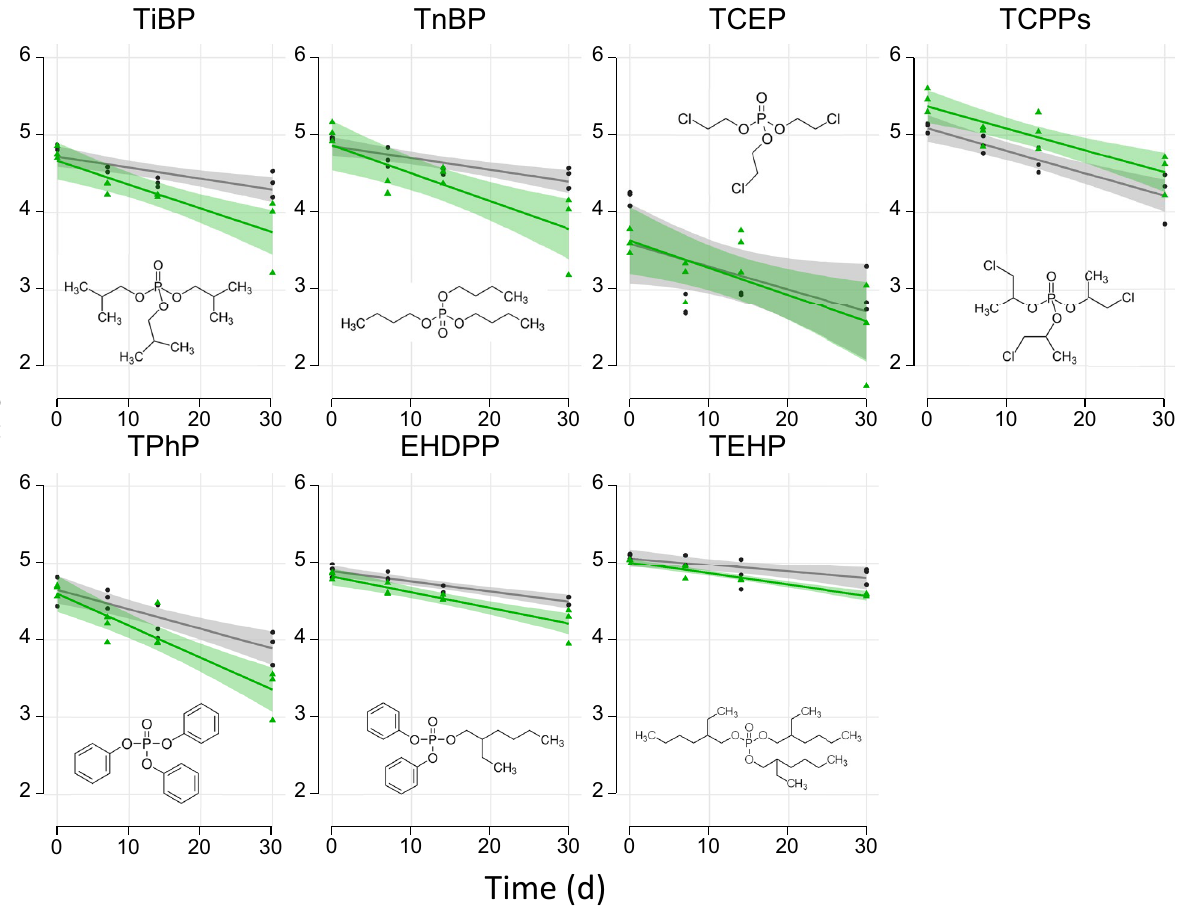
Figure 1. Linear regression analysis between the individual OPE concentrations (as Ln C) and the incubation time (days). Gray and green lines represent abiotic and biotic conditions, respectively. The shaded areas indicate the 95% confidence interval. All details from the regression analysis are presented in Table 1. Three replicates are plotted for each incubation time and condition (see materials and methods).